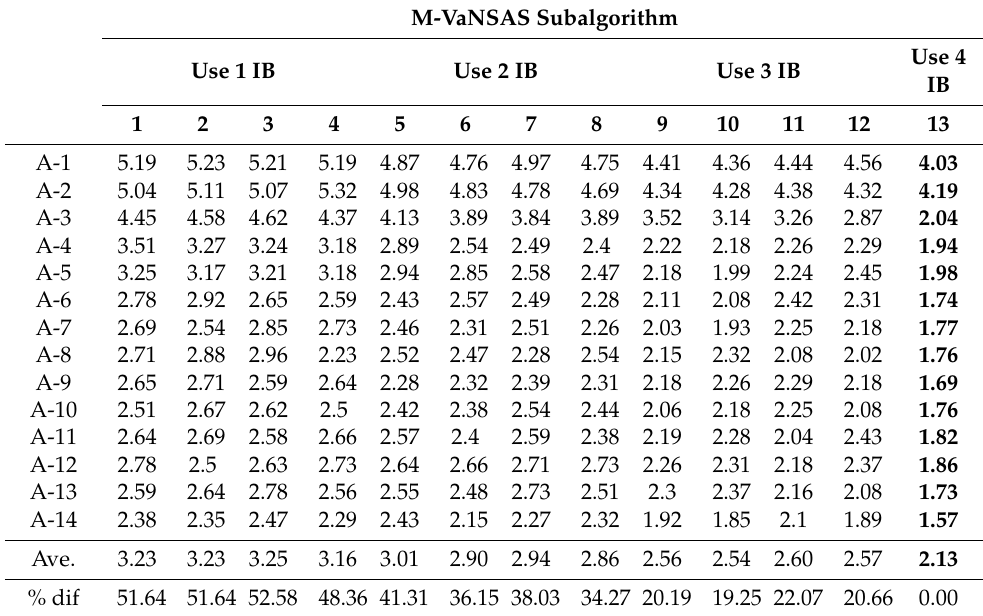
Table 15. Average cost per population (baht/person) of using the different proposed